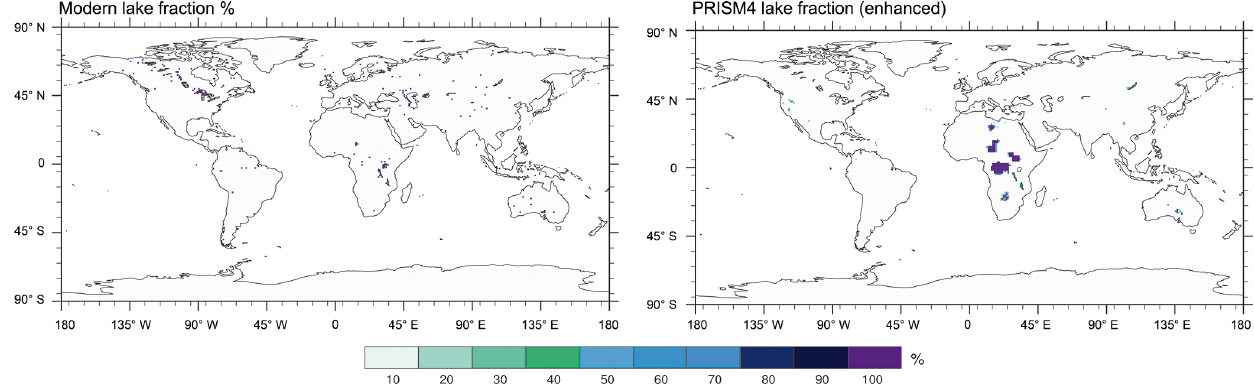
Figure 5. Modern and Pliocene (PRISM4) fractional lake coverage data set (Pound et al., 2014). Modern data are based upon the FAO / UNESCO modern soil map (Version 3.6).